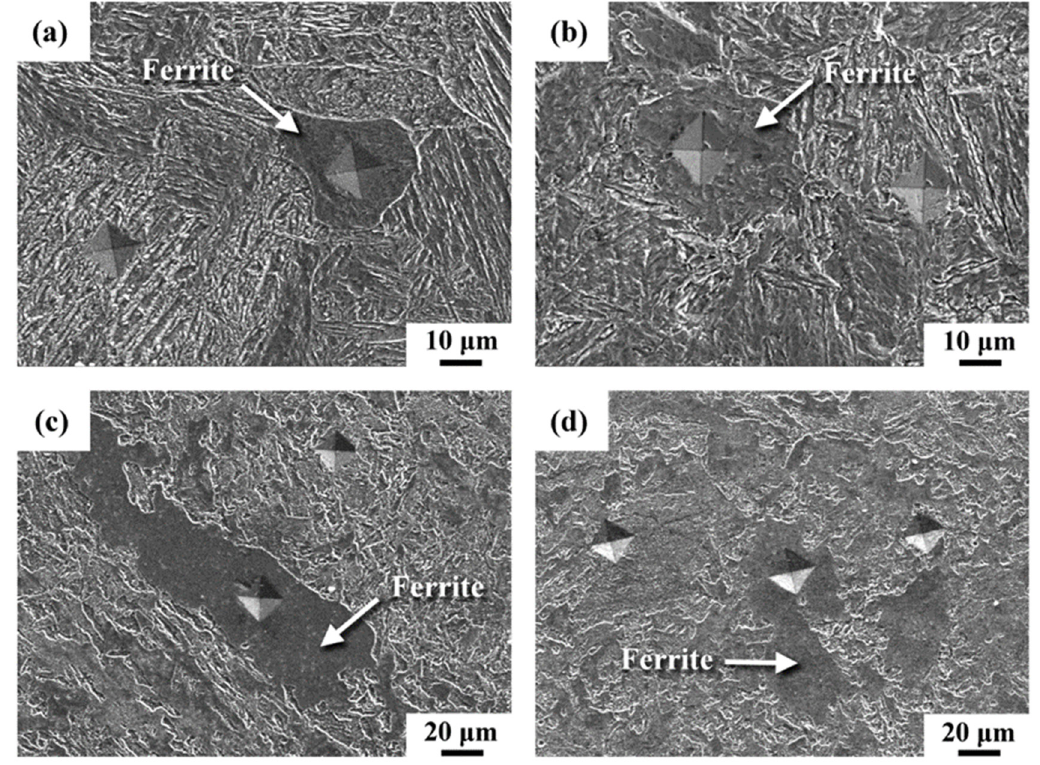
Figure 5. The hardness indentation on the ferrite and lath martensite in distinct samples: ( a ) W, ( b ) WP, ( c ) WP-800P and ( d ) WP-860P specimens.